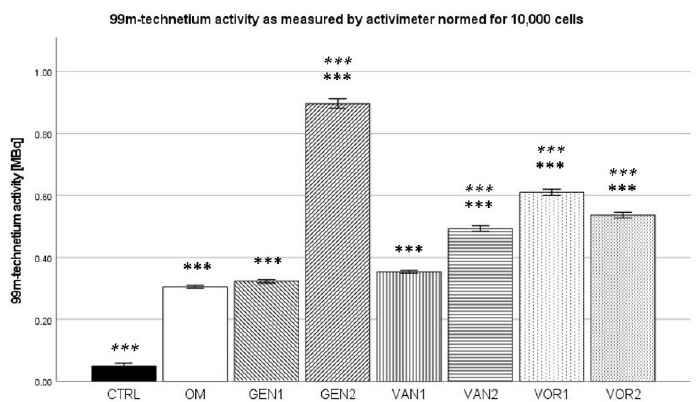
Figure 10. Mean 99m technetium uptake per group as measured by the activimeter. The error bars show the error of mean.